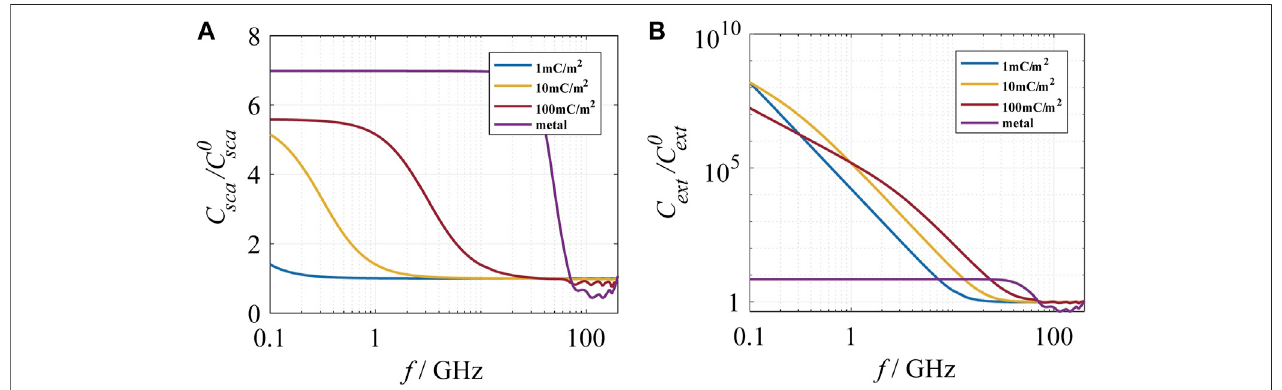
sca and C 0 sca denote the scatteringcross section